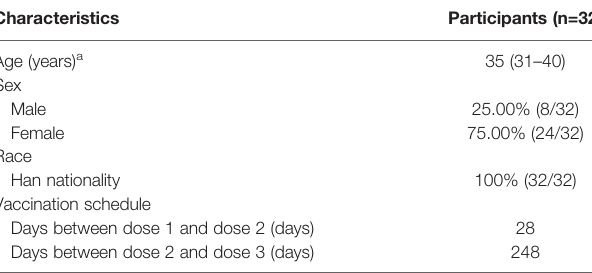
TABLE 1 | Characteristics of the